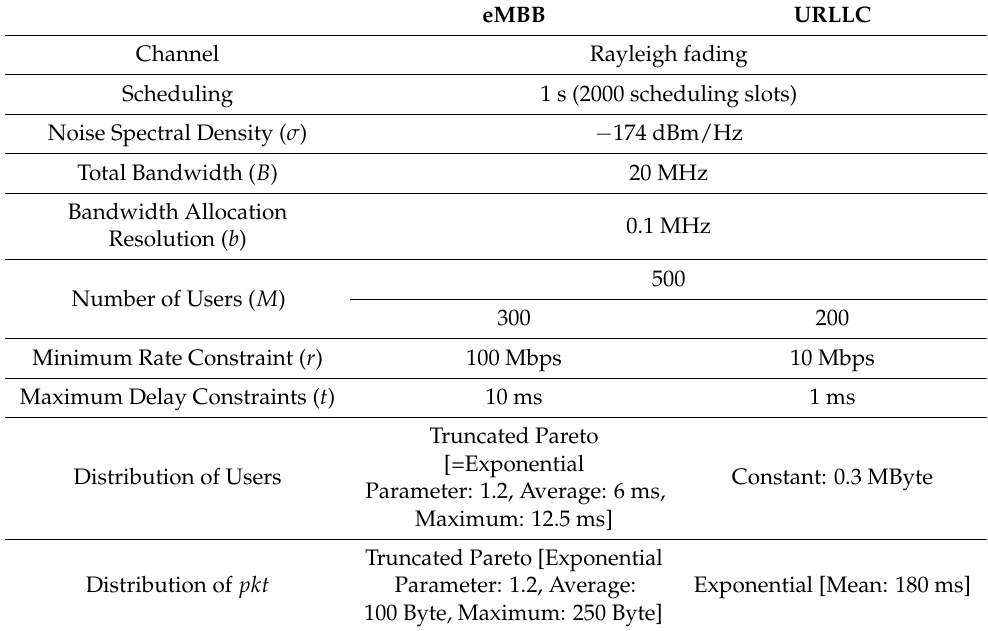
Table 1. Simulation